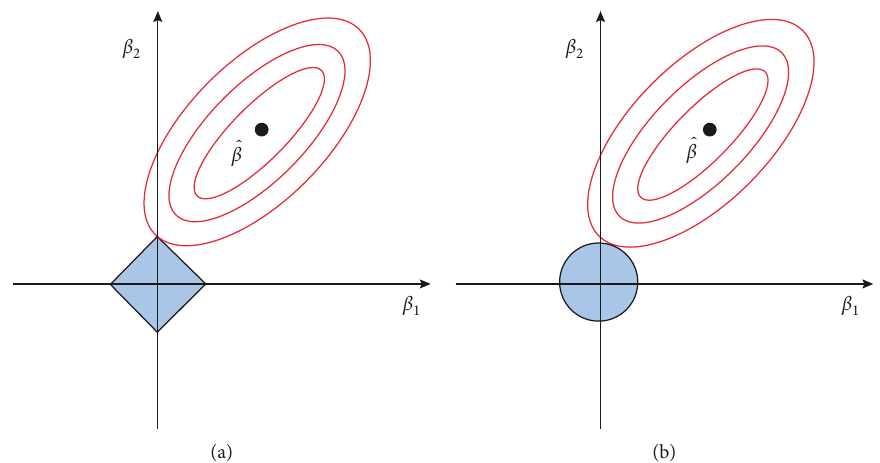
Figure 1: Geometric explanation of lasso and ridge regression.